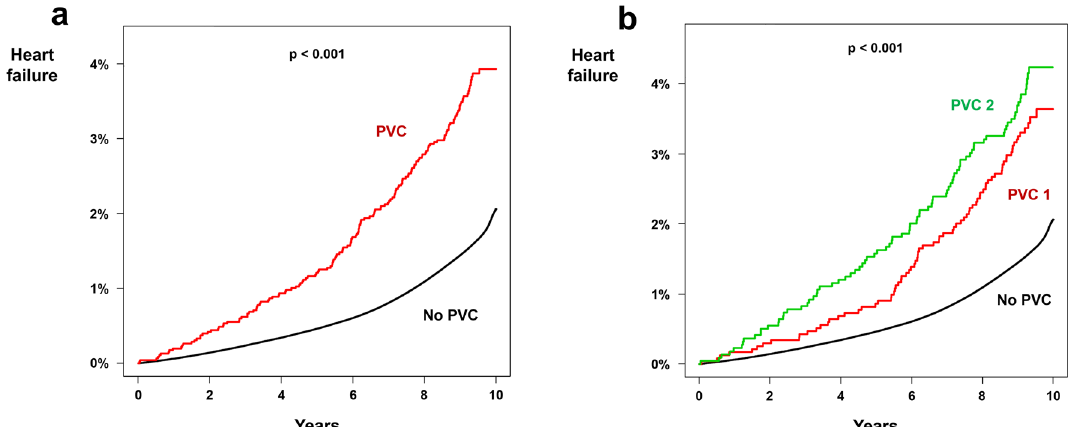
Figure 2. Impact of PVC on heart failure. Kaplan–Meier curve analysis showed significantly higher incidence of heart failure in people with PVC (a) as compared to people without PVC. People with PVC 2 had an even higher risk of developing heart failure (b) . PVC: premature ventricular